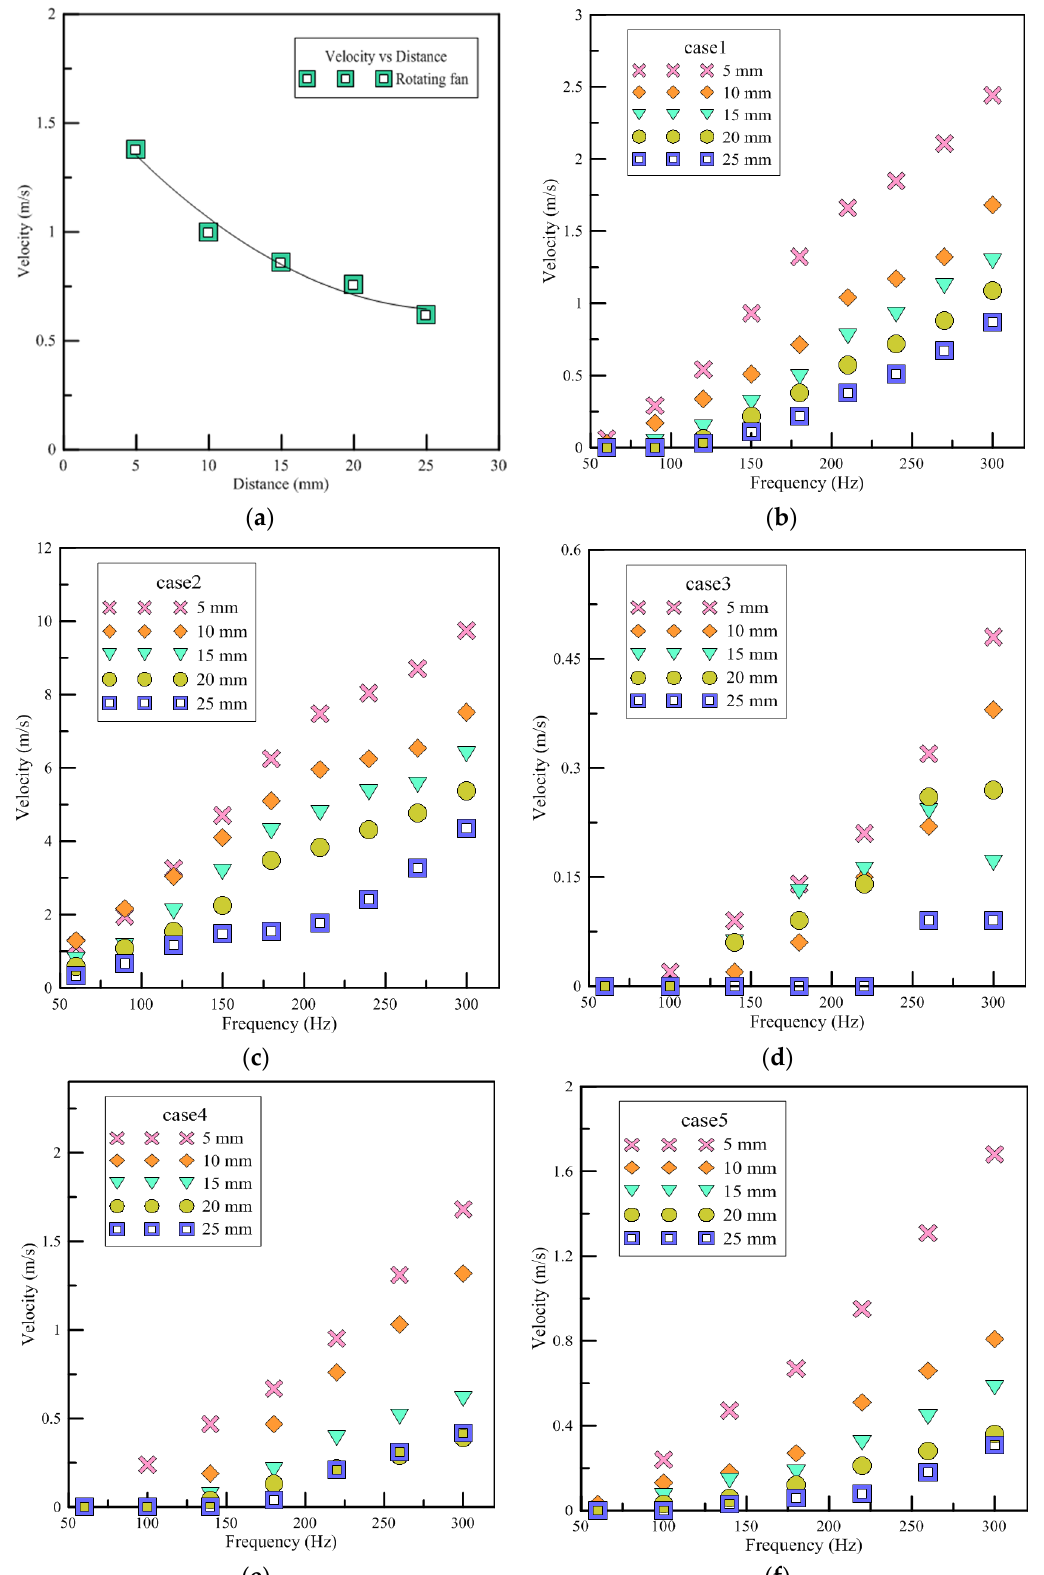
Figure 10. Each device when the wind speed and placement diagrams under different frequencies. ( a ) Rotary fan ( b ) Case1 ( c ) Case2 ( d ) Case3 ( e ) Case4 ( f ) Case5.